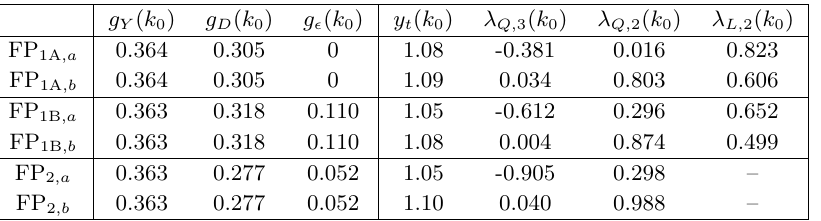
Table 3 . Values of the gauge and Yukawa couplings of the scenarios investigated in this work at the reference “collider” scale of k